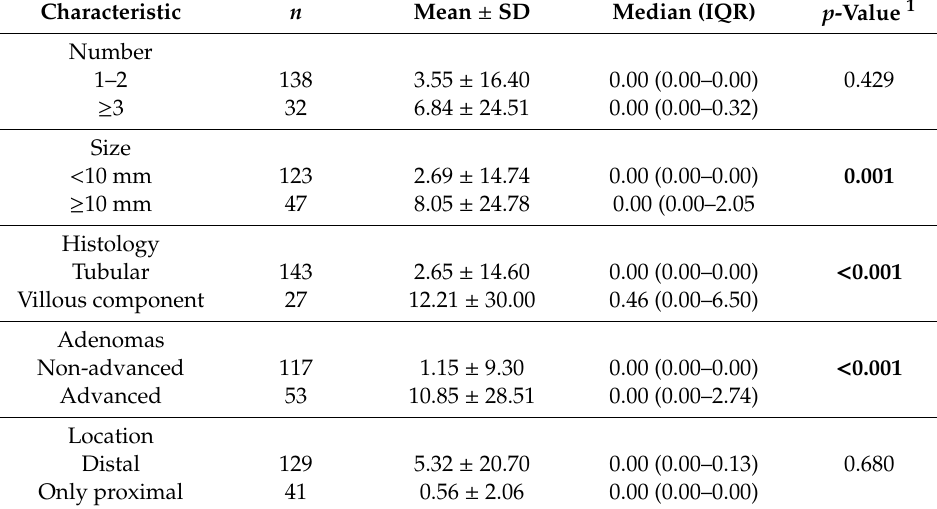
Table 2. Serum NEUROG1 methylation according to the characteristics of adenomas in the screening